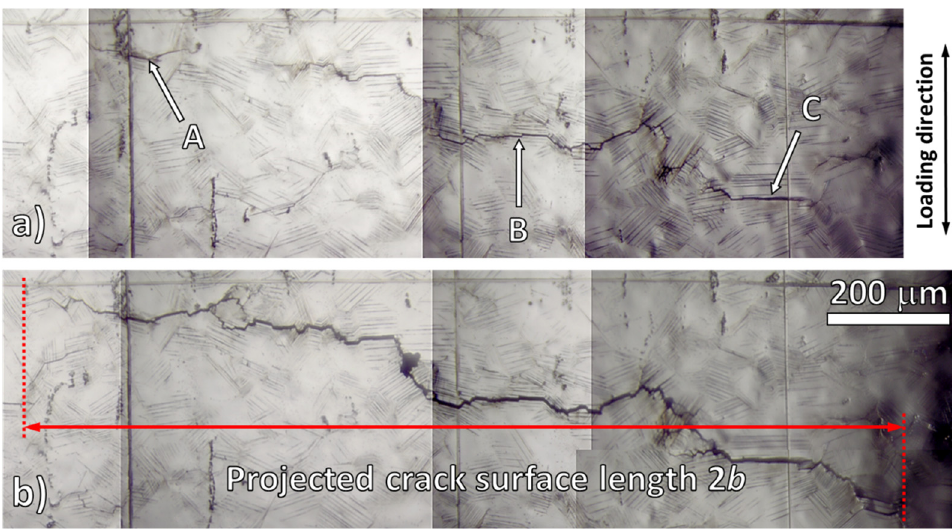
Figure 4. Crack growth at the surface of Sanicro 25 cycled at ε a = 2.5 × 10 − 3 . Crack propagation is shown in two stages of cycling: ( a ) at N = 25,000 cycles where A, B, C depicts independently initiated cracks; ( b ) N f = 37,500 cycles where underwent coalescence of cracks is evident. The estimation of projected surface crack length is outlined.